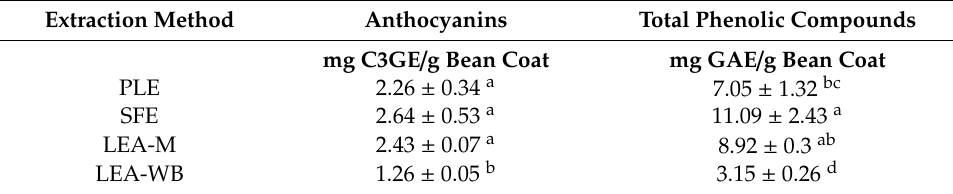
Table 1. Anthocyanins and total phenolic compounds from di ff erent extraction